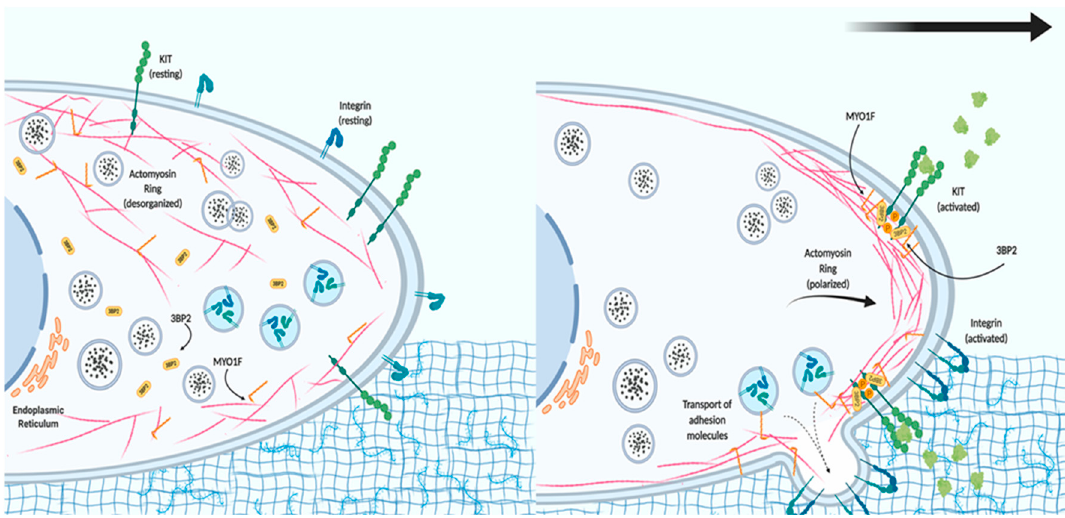
Figure 2. The role of MYO1F in mast cell migration. In resting conditions, mast cells express tyrosine-protein kinase KIT receptor and different integrins on the cell membrane. The actin cytoskeleton and MYO1F are distributed along the cell membrane and in the cytoplasm, whereas Src homology 3 domain (SH3)-binding protein 2 (3BP2) is mostly found in the cytoplasm. Activation of the KIT receptor initiates actin remodeling, which generates the leading edge (consisting of actin filaments) necessary for cell movement. MYO1F is necessary for the secretion and localization of activated integrin molecules that will induce adhesion to the extracellular matrix and aid cell migration.